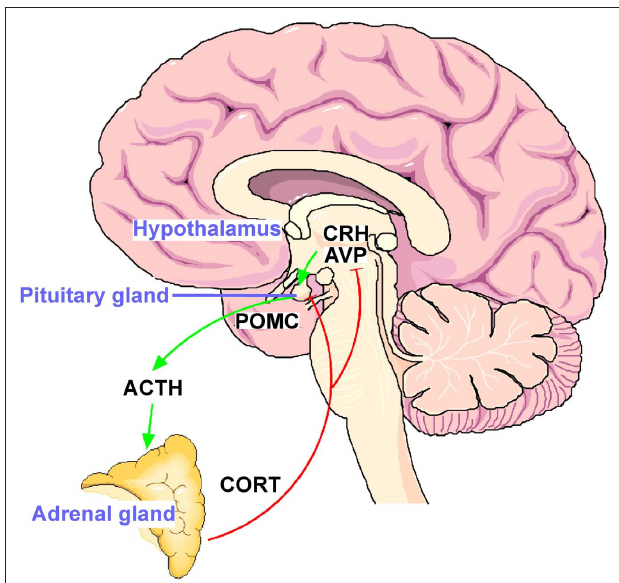
Figure 1 | The hypothalamo–pituitary–adrenal (HPA) stress axis. The neuropeptides corticotropin-releasing hormone (CRH) and arginine vasopressin (AVP) are expressed in the parvocelluar neurons of the hypothalamic nucleus paraventricularis. The joint release of CRH and AVP into the portal blood vessels leads to potent stimulation of anterior pituitary ACTH secretion and in turn of corticosterone from the adrenal glands. The activational effects of the HPA axis are counteracted by the inhibitory effects of glucocorticoid receptors expressed in the hippocampus, hypothalamus, and anterior